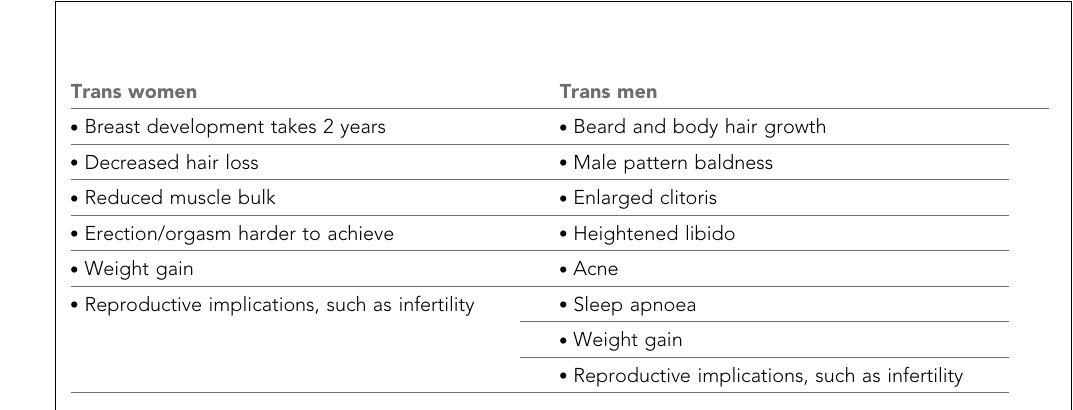
Box 1. Side-effects of hormonal preparations for trans men and women.